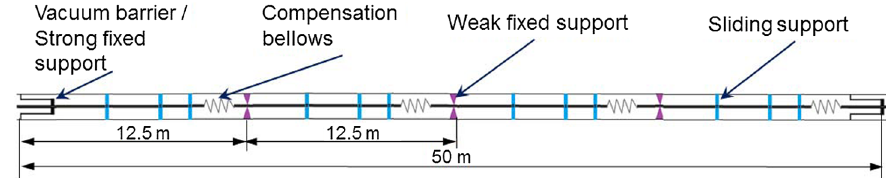
FIG. 2. Schematic view of a 50 m section of a cryogenic transfer line based on standard design solutions.